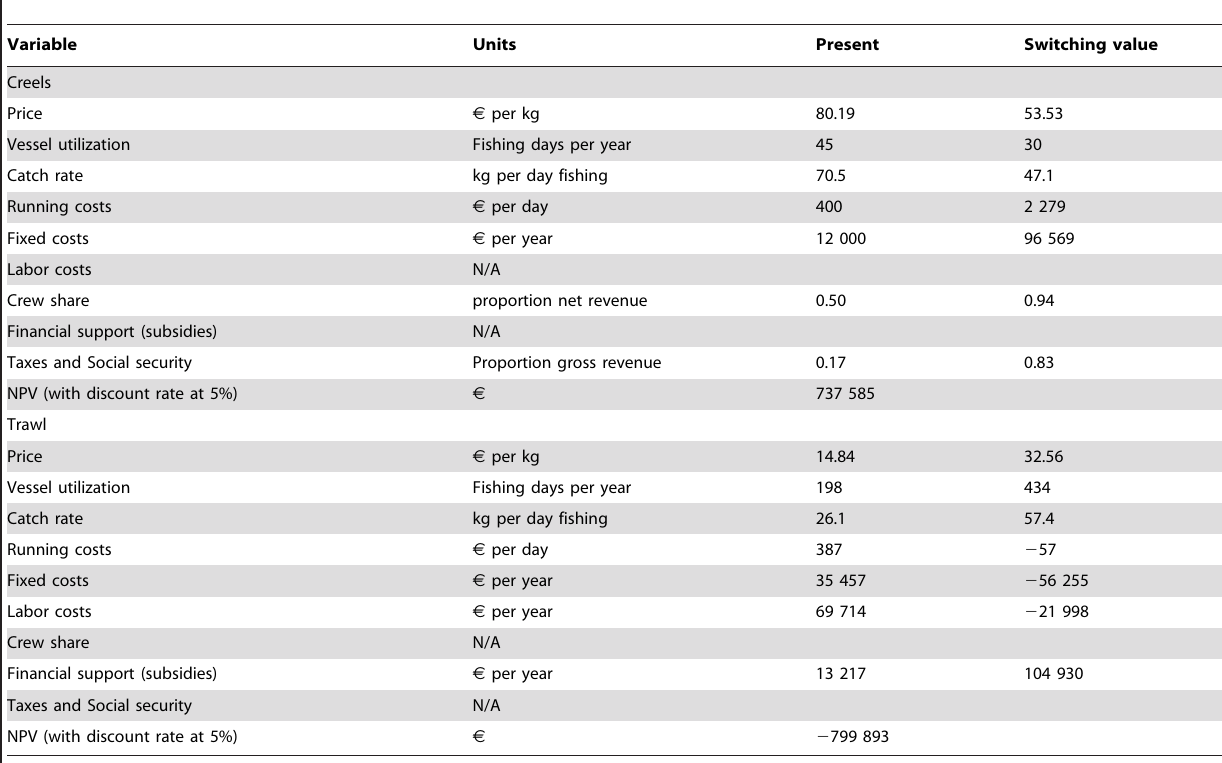
Table 5. Baseline values used in the Net Present Value (NPV) analysis and switching values from sensitivity